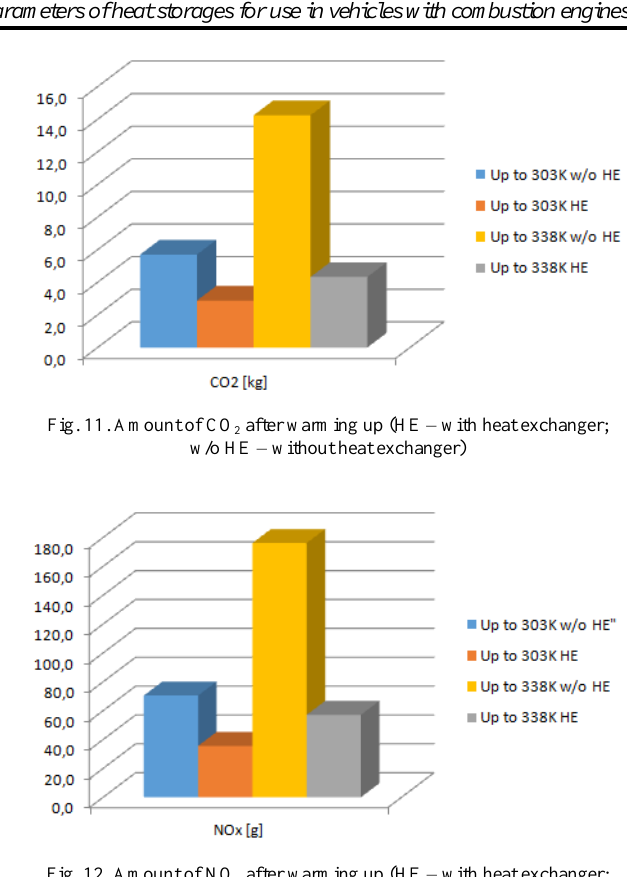
Fig. 12. Amount of NO x after warming up (HE – with heat exchanger; w/o HE – without heat exchanger)